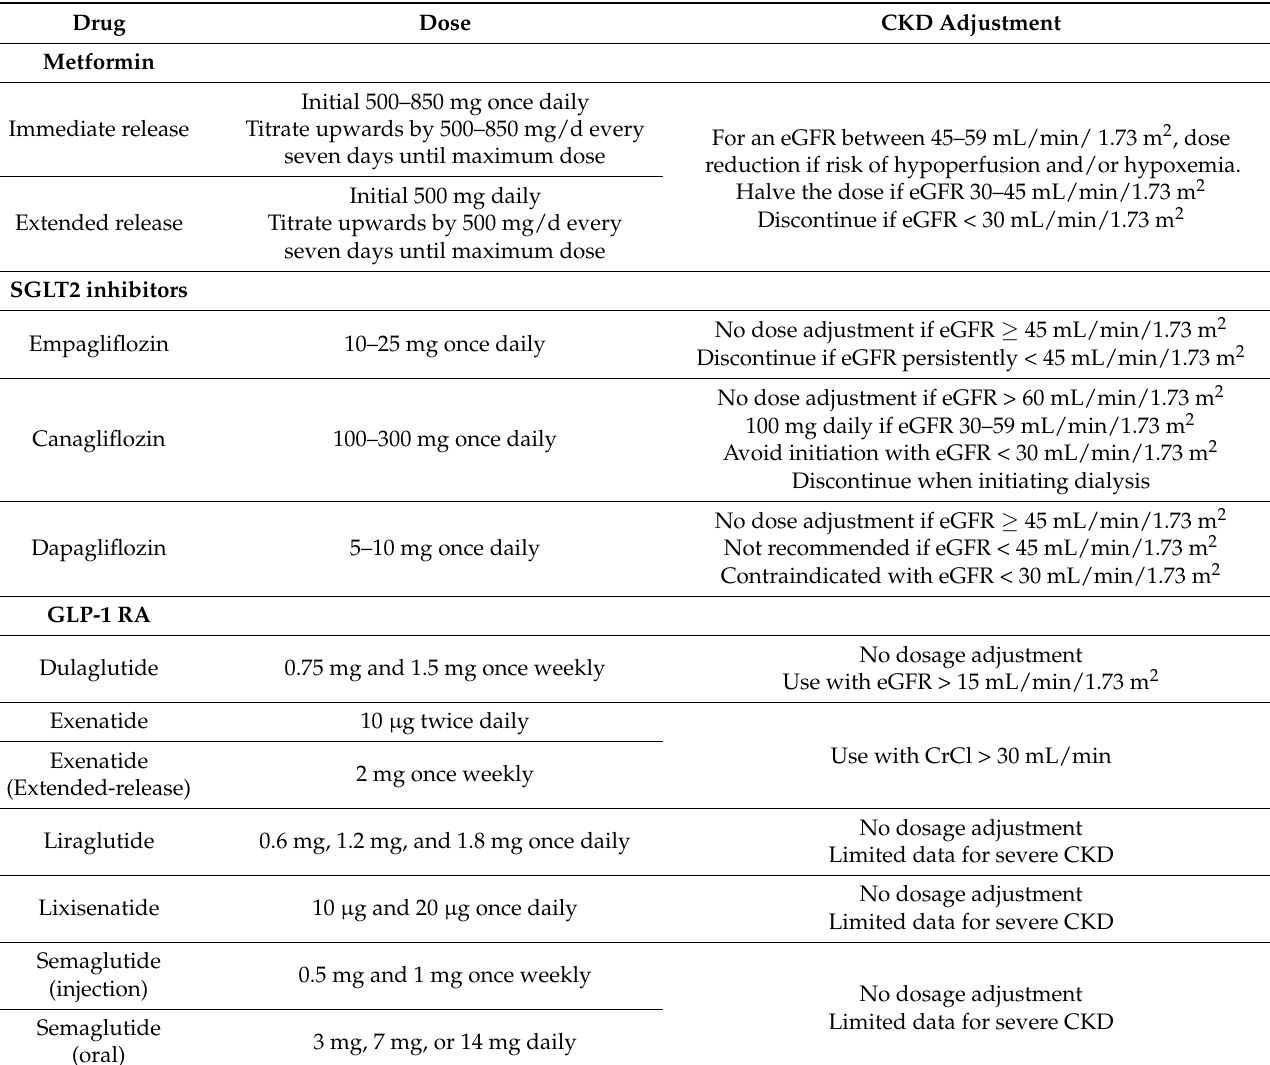
Table 2. Usual and renal function-adjusted doses of Metformin, SGLT2 inhibitors and GLP-1